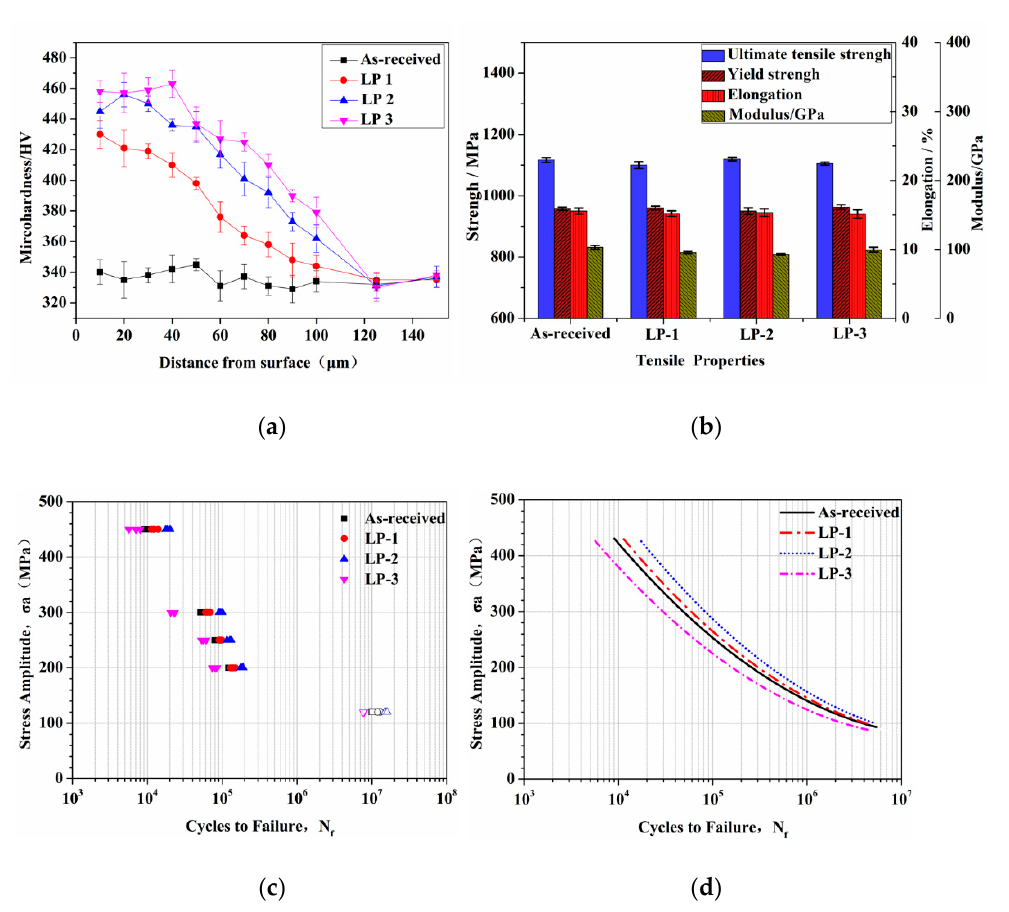
Figure 7. Mechanical properties: ( a ) microhardness distributions in the laser-polished layer, ( b ) tensile properties, ( c ) stress–life fatigue behavior for all geometries showing combined data points, and ( d ) stress life fatigue